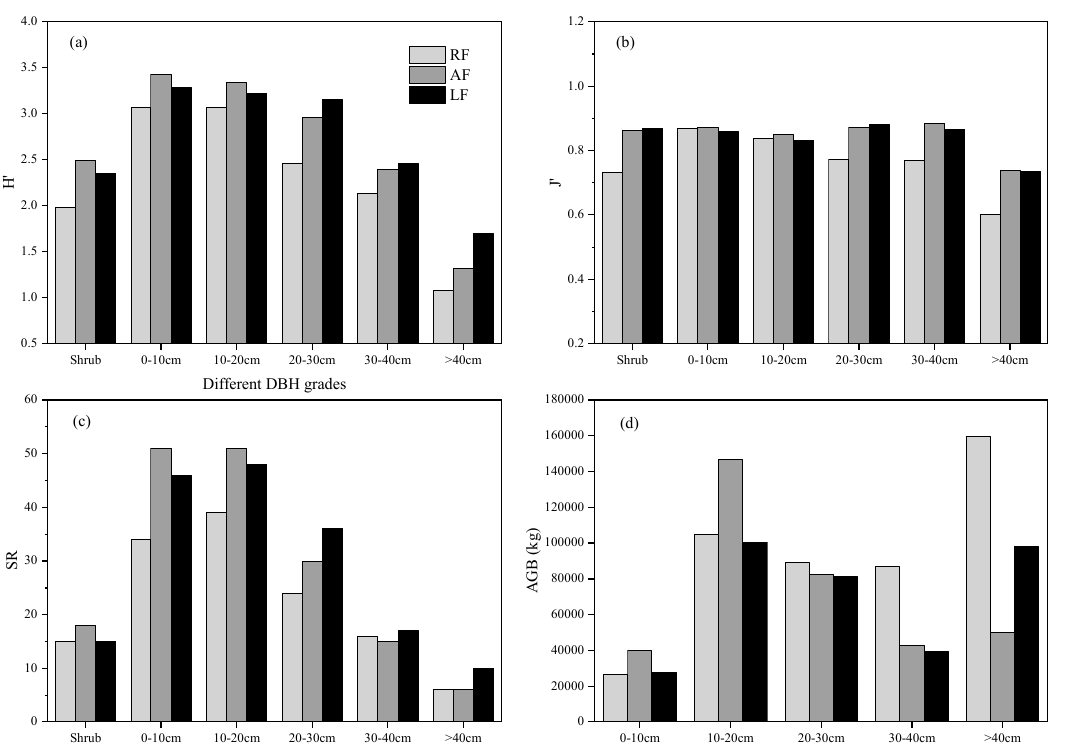
Figure 4. Distribution attributes of species diversity indexes and above-ground biomass with different DBH grades in various forest types. ( a ) depicts the magnitude of Shannon–Wiener index (H’) at DBH grades for different forest types; ( b ) depicts the magnitude of evenness index (J’) at DBH grades for different forest types; ( c ) depicts the magnitude of species richness (SR) at DBH grades for different forest types; ( d ) depicts the magnitude of above-ground biomass (AGB) at DBH grades for different forest types. RF, road forest; AF, attached forest; LF, landscape and relaxation forest.